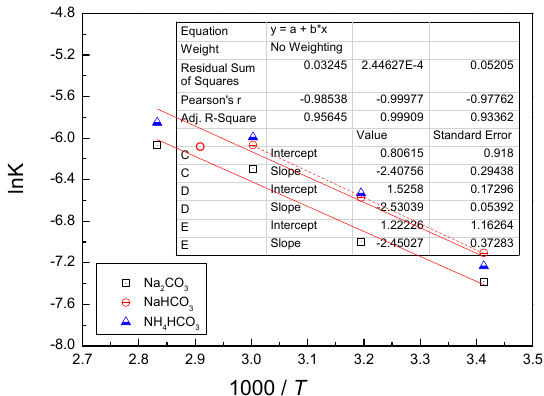
Figure 12. The relation between ln K and 1/ T in different solutions.